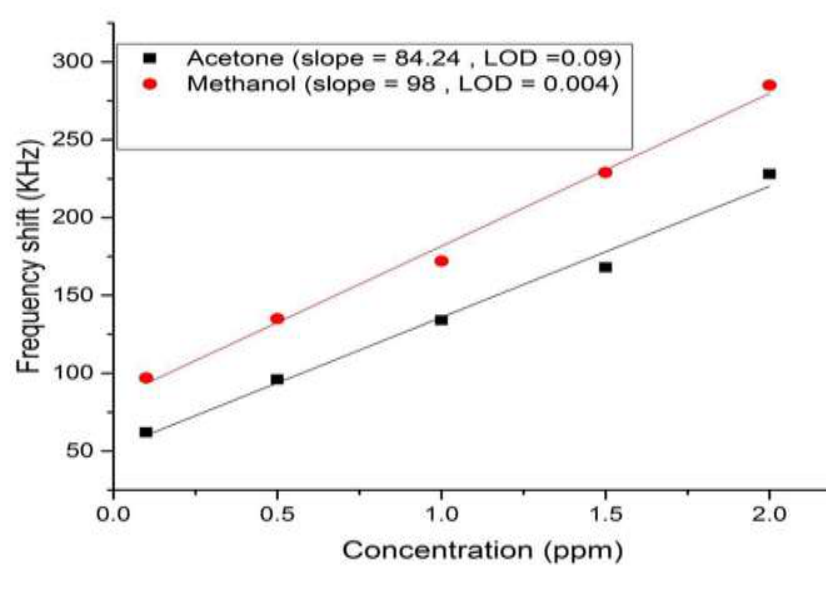
Figure 11: Relation between the frequency shift Δf and the Chlorpyrifos concentration (0.1 to 2 ppm) in methanol and